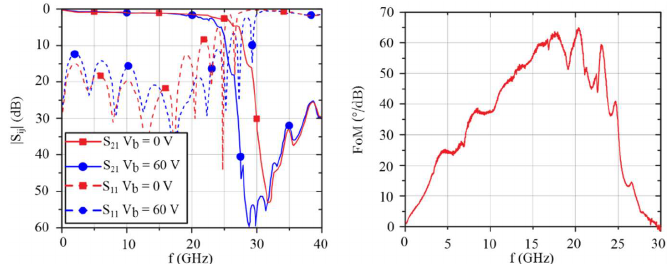
Figure 25. Measured S-parameters for the two extreme tuning states for V b =0V and V b =60V and the FoM versus frequency [185]. Reprinted from [2], Cambridge University Press, 2020.